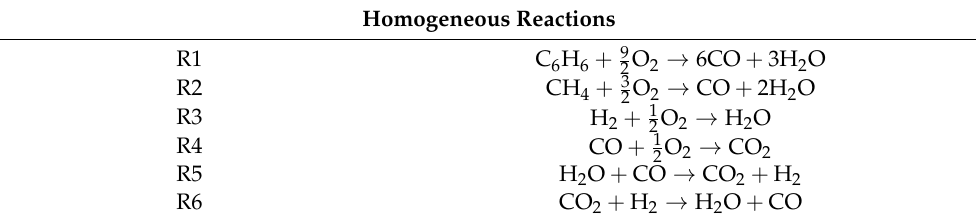
Table 2. Combustion